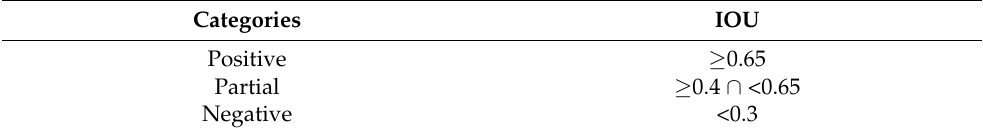
Table 3. Categories of training